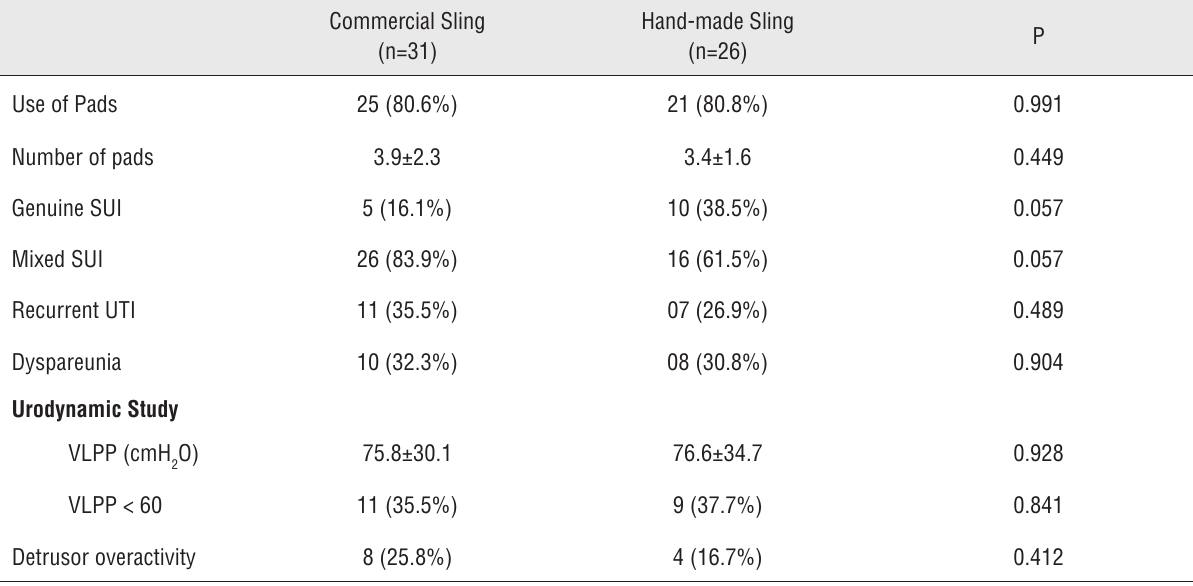
Table 2 – preoperative urinary symptoms. Data expressed in (mean±standard deviation) or n